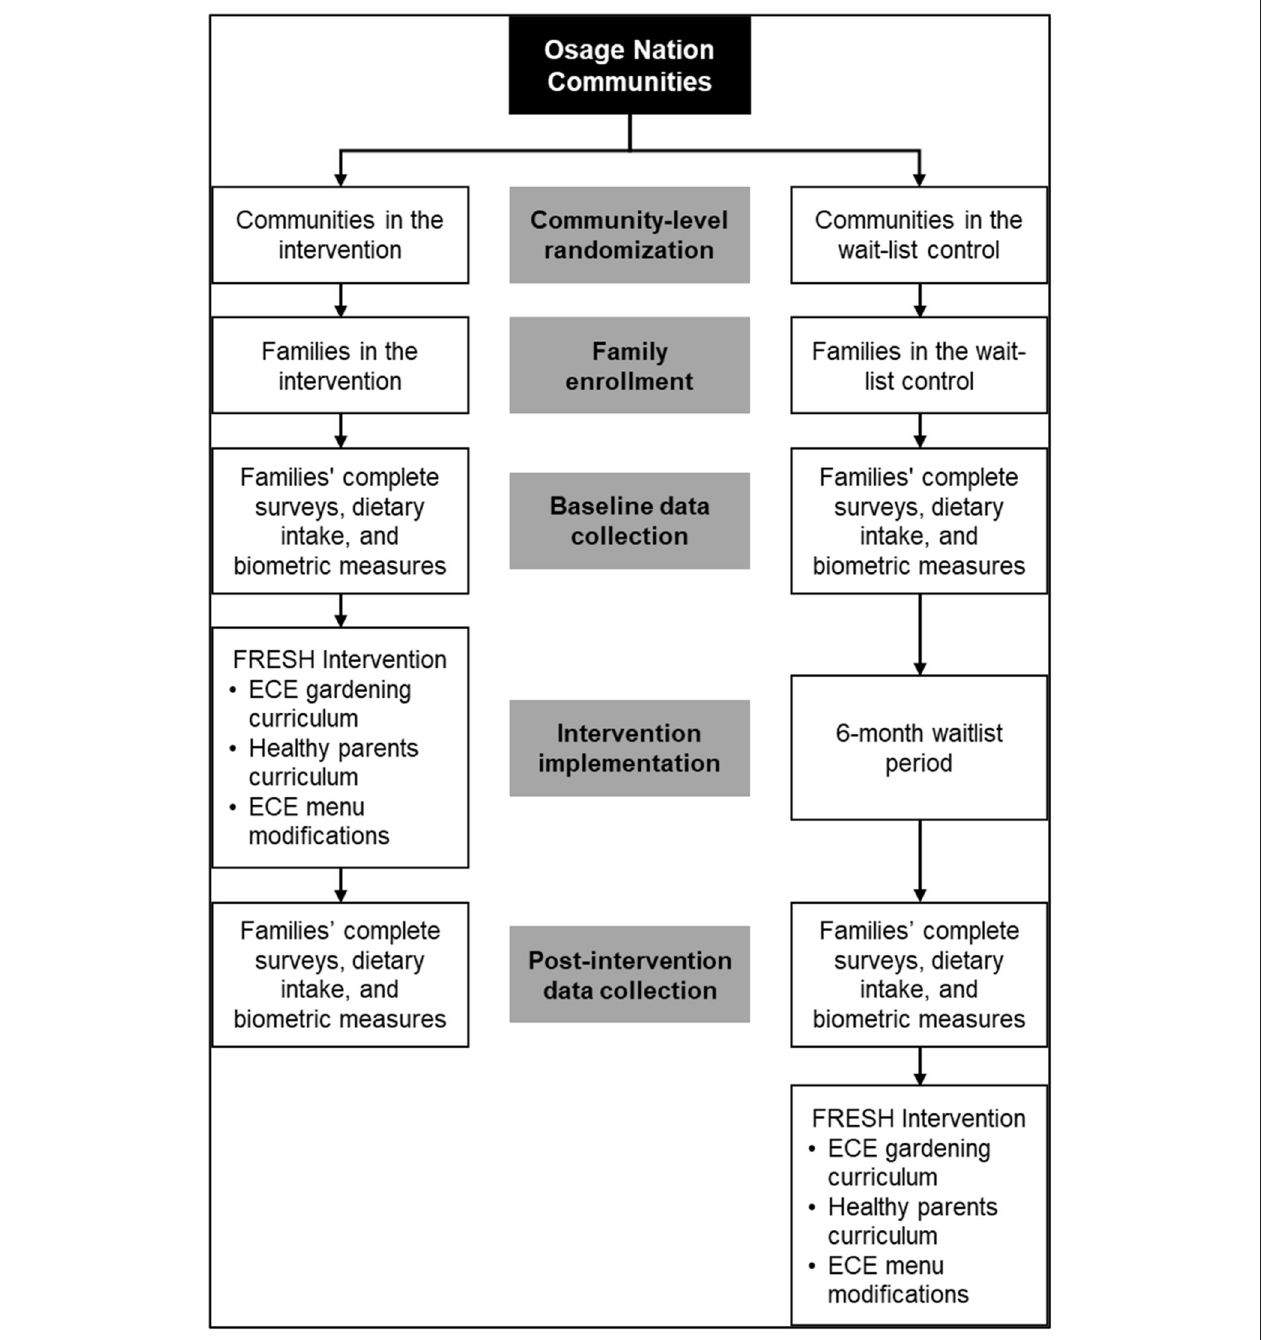
FIGURE 2 | Study design for the Food Resource Equity and Sustainability for Health (FRESH) randomized, wait-list controlled trial.